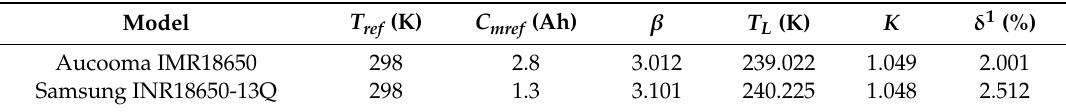
Table 1. Optimal values of parameters for Equation